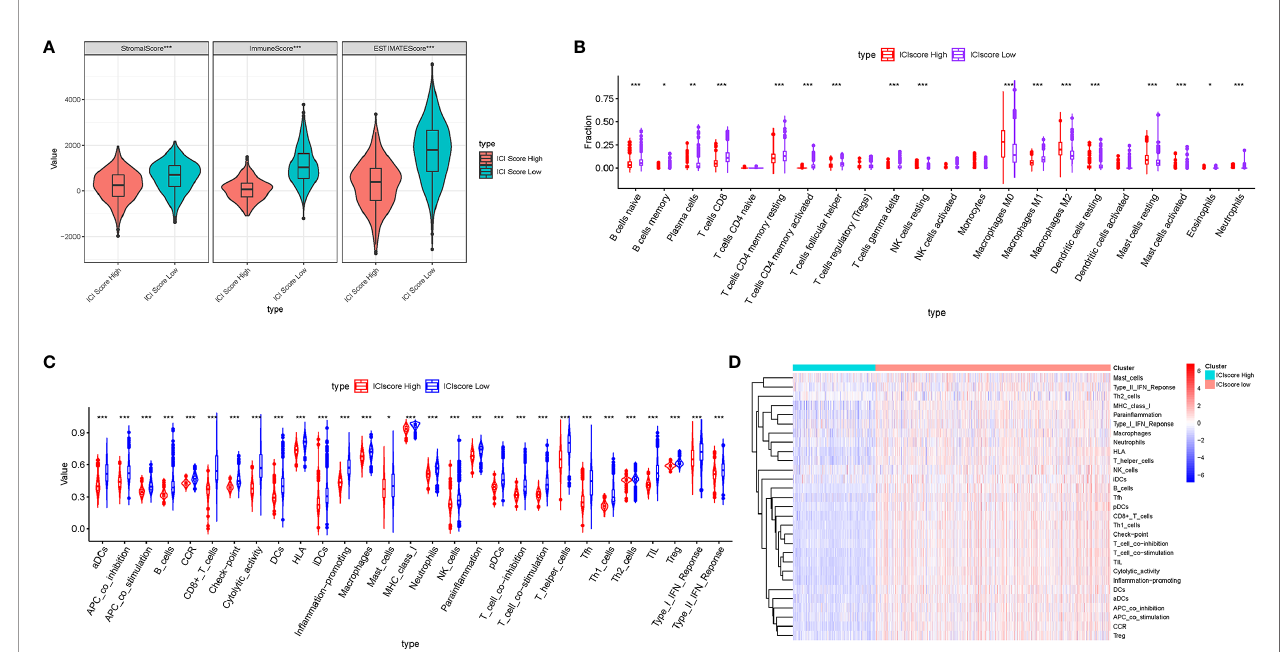
FIGURE 7 | Correlation of ICI score with the characterization of TIME. (A) Comparison of the ESTIMATE algorithm (estimate score, stromal score, and immune score) between patients who obtained different ICI scores. (B) Difference of in fi ltrating immune cell subpopulations and levels between the low-/high-ICI score groups. Violinplot (C) and heatmap (D) of distinction of enrichment of immune-related signatures between the ICI score-low and ICI score-high groups. The asterisks represented the statistical p value (*P < 0.05; **P < 0.01; ***P <